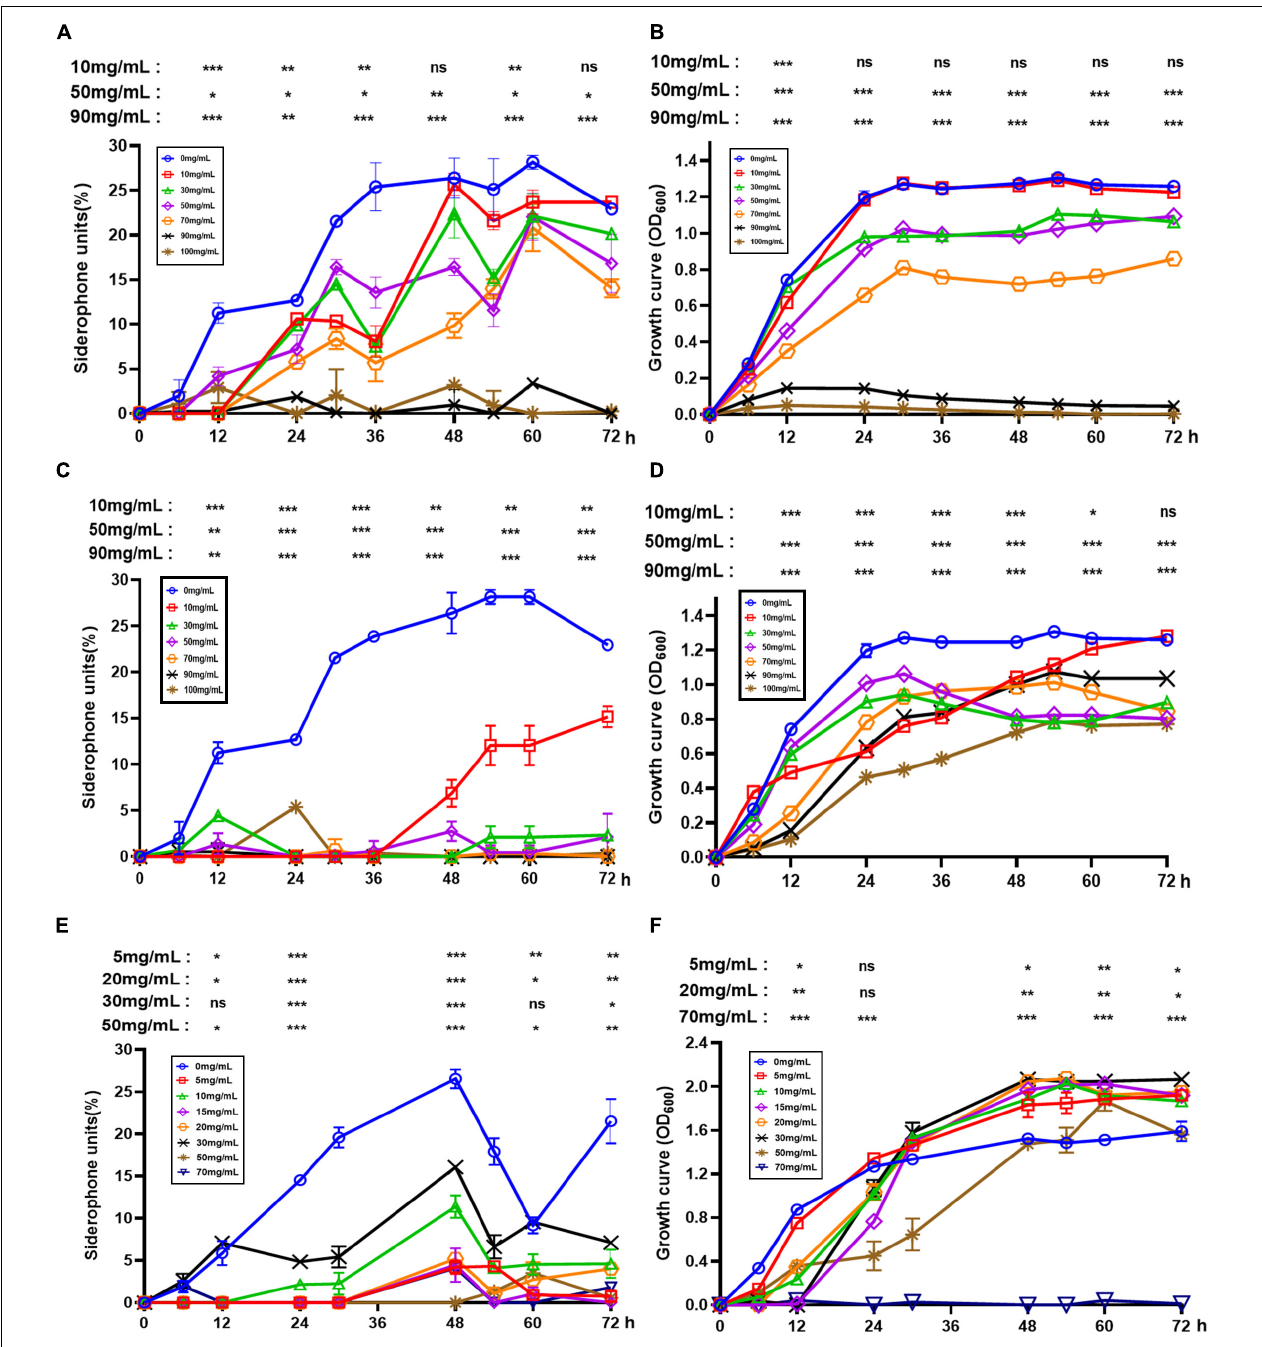
FIGURE 5 | Effects of urea, KH 2 PO 4 and NPK on the growth and siderophore production of AS19. (A) Siderophore production at different concentrations of urea. (B) The growth curve at different concentrations of urea. (C) Siderophore production at different concentrations of KH 2 PO 4 . (D) The growth curve at different concentrations of KH 2 PO 4 . (E) Siderophore production at different concentrations of NPK compound fertilizer. (F) The growth curve at different concentrations of NPK compound fertilizer (ns, no significant difference, * p < 0.05, ** p < 0.01, *** p <